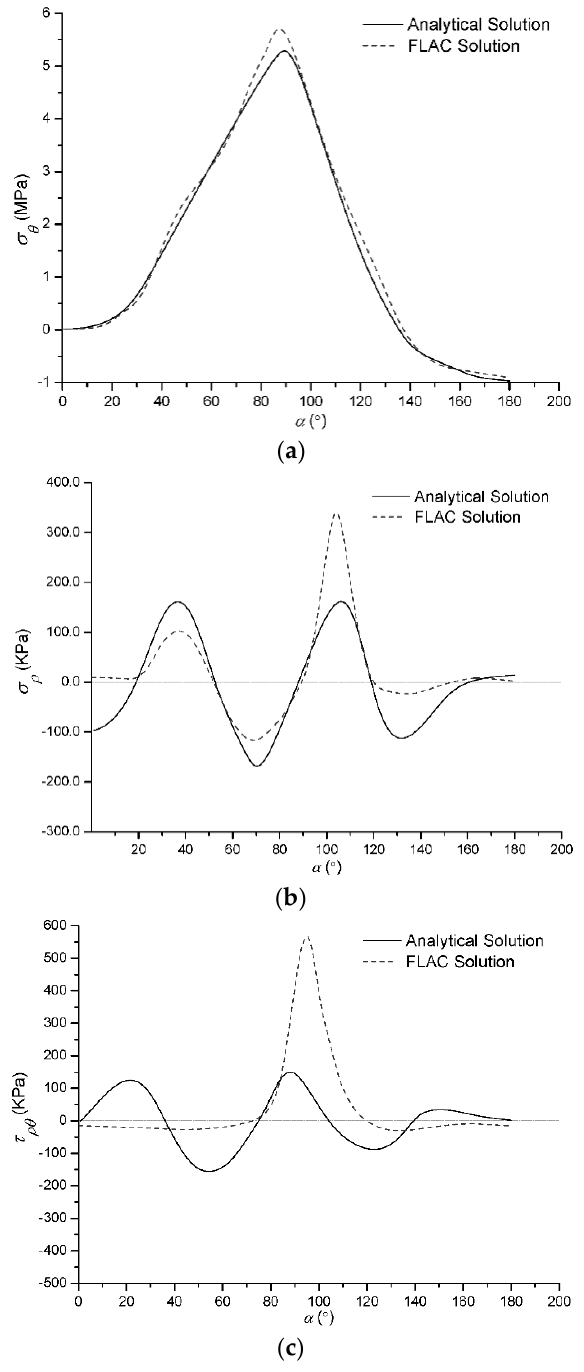
Figure 4. Stress along the inner lining periphery ( a ) circumferential stress ( b ) normal stress ( c ) shear stress.